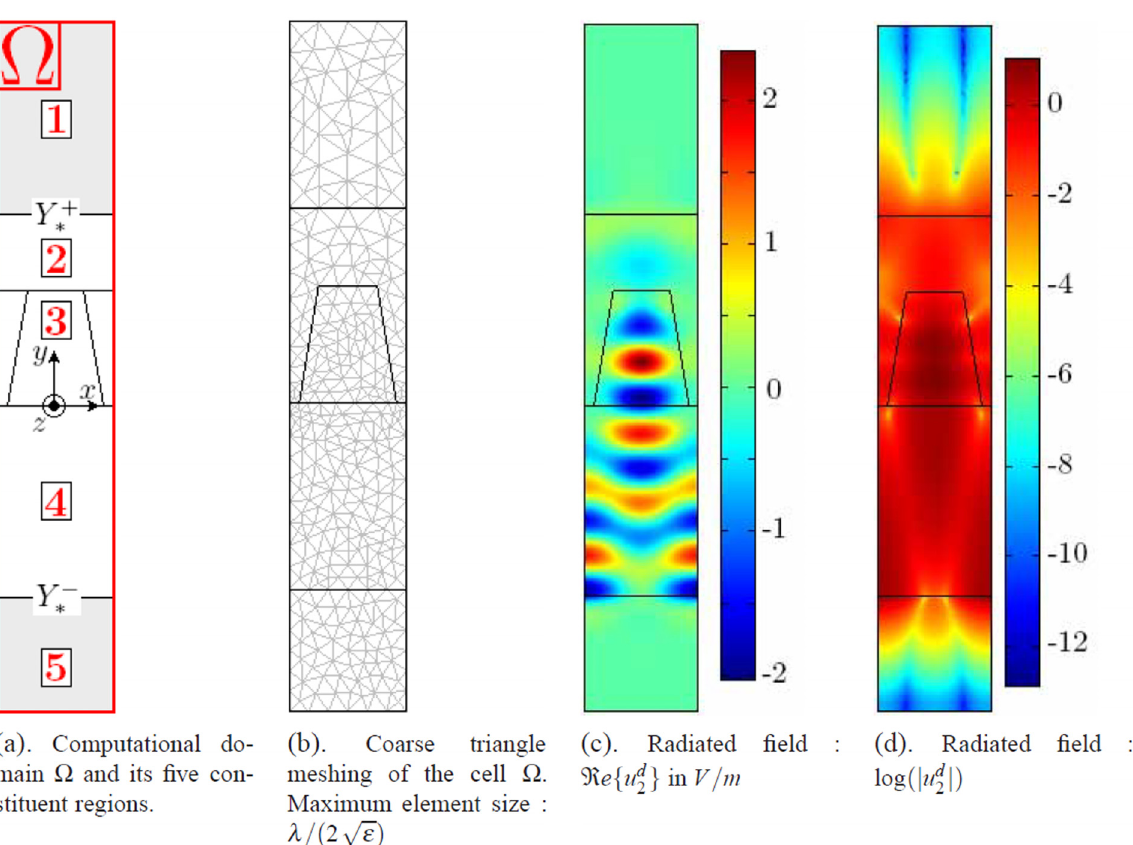
Figure 27. Diagram of FEM simulation, including meshing scheme. Figure Reprinted with permission from reference [123], Copyright 2007 Optical Society of